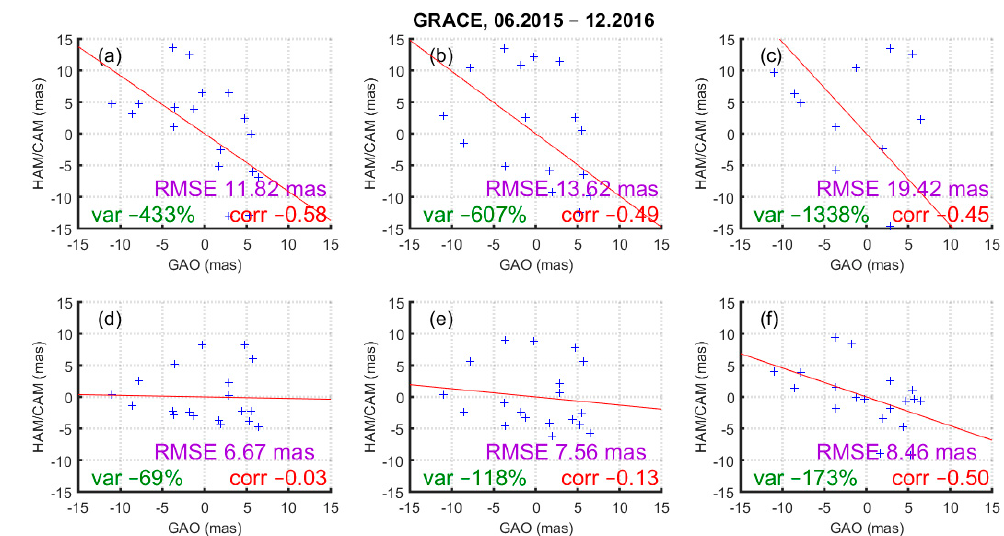
Figure 10. Scatter plots showing the relationship between the χ 1 component of GAO and HAM/CAM from ( a ) CSR GSM, ( b ) JPL GSM, ( c ) GFZ GSM, ( d ) CSR TWS, ( e ) JPL TWS, and ( f ) GFZ TWS. The red line was fitted to the data points using the least squares method. The values in purple indicate the RMSE, the values in red (corr) indicate the correlation coefficients between series, and the values in green (var) indicate the relative explained variances. The considered time period is June 2015 to December 2016. Note that the critical value of correlation coefficient for 12 independent points and a 95% confidence level is 0.50, while the standard error of the difference between two correlation coefficients is 0.47. All the parameters were computed after removal of trends.